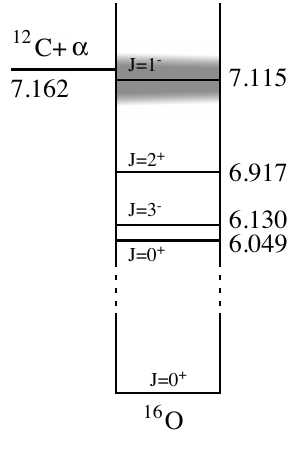
Figure 8.19: The struc- Figure 14: The structure of 16 O based on Ajzenberg ture of the oxygen nu- & Lauritsen 1952. The partial width of the relevant level at 7.115MeV is not known because it is a very cleus 1952. Based on difficult measurement. The uncertainty in the level is marked by the grey zone around the level. The diffi- 1952. culty stems from the fact that the level lies just below the continuum and hence extremely difficult to feed in.